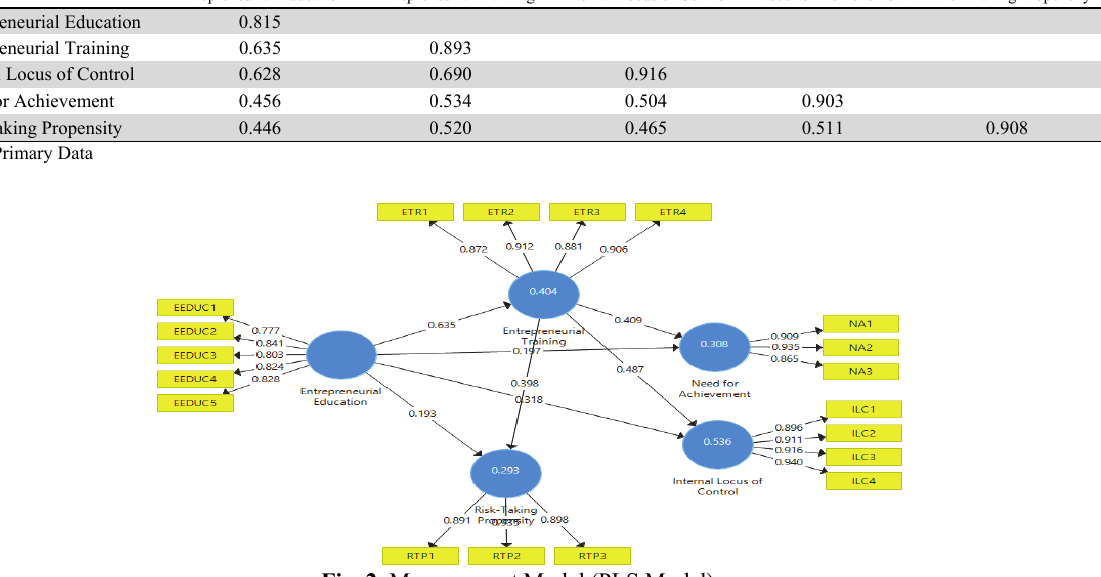
Source: primary Data